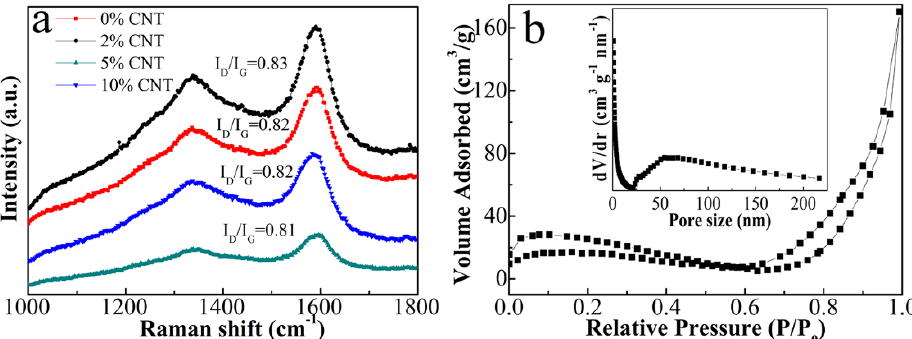
Figure 2. ( a ) Raman spectra of the composites with different contents of CNTs; ( b ) nitrogen adsorption/desorption isotherm of 5% CNT.